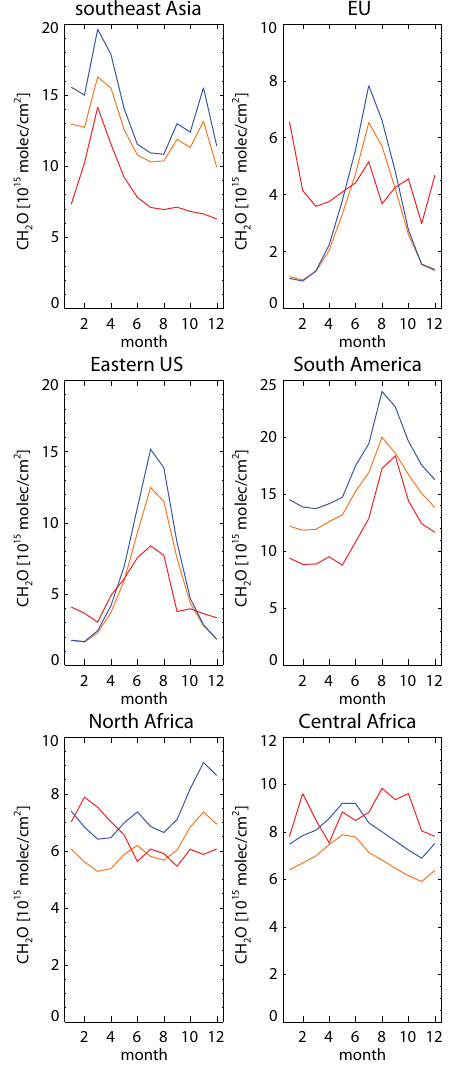
Fig. 9. The annual cycle of monthly averaged tropospheric columns of CH 2 O for selected global regions for the BA (blue), MBA (dark yellow) and SCIAMACHY (red). For the latitudinal and longitudi- nal constraints of each region the reader is referred to the legend of Fig.